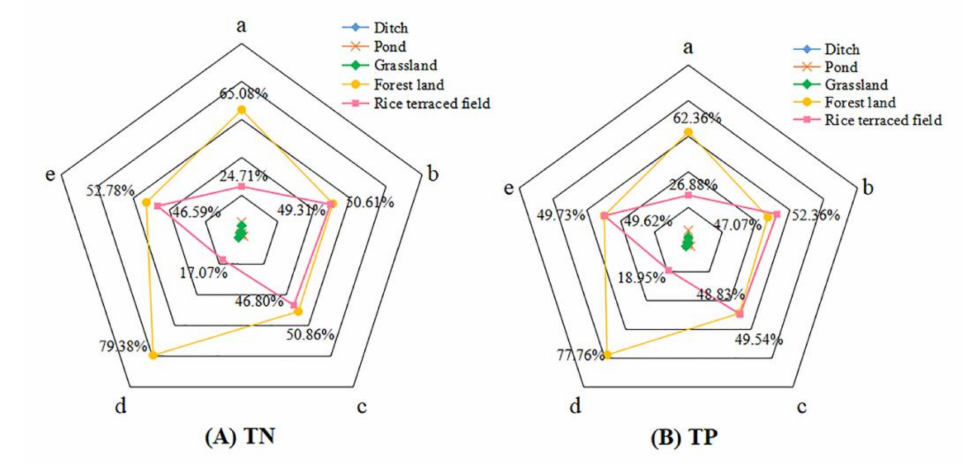
Figure 4. The retention contribution rates of different sink landscapes in the five